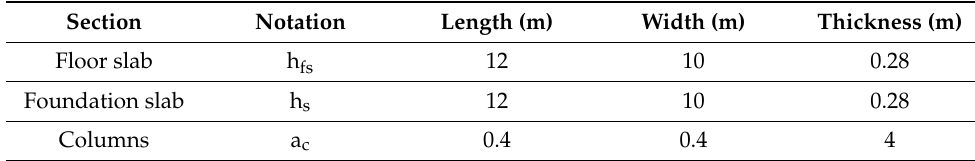
Figure 3. Column and slab sections in the 5-storey concrete-frame building. Table 1. Structural sections considered in the building.